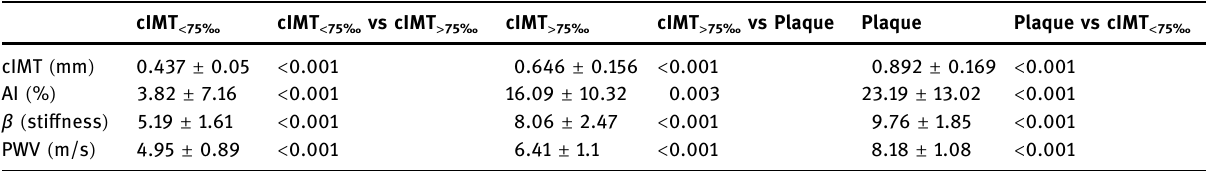
Table 2: Vascular changes in study groups cIMT < 75